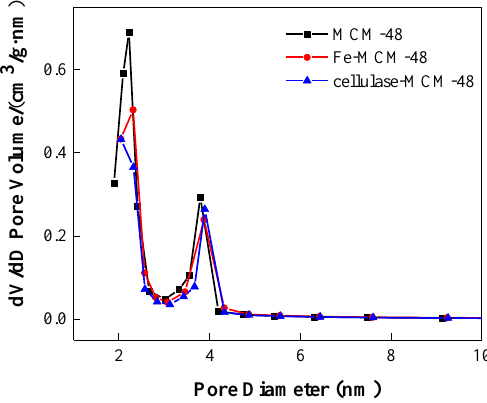
Figure 2. Pore size distribution of MCM-48 catalysts.